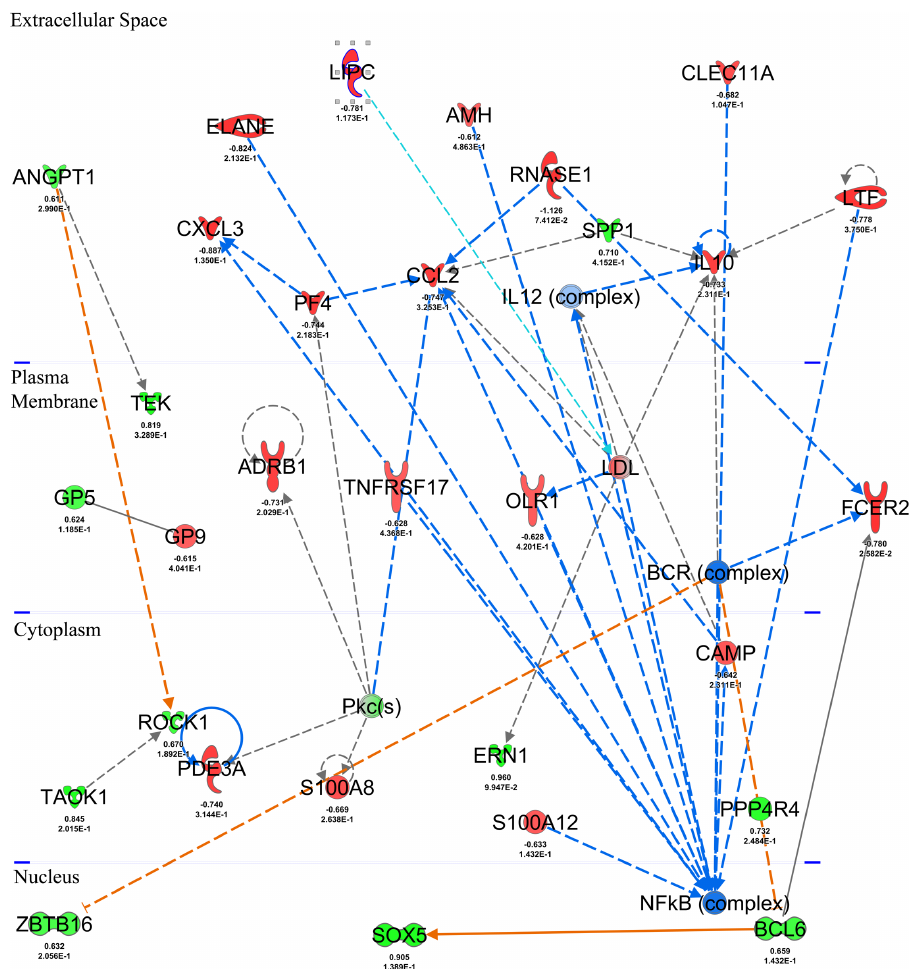
Fig 3. Ingenuity top gene network interaction reflecting immune response-related transcriptome changes after consumption of LGG. Nodes in the interaction network are encoded by differentially expressed genes detected by edge-R in blood from subjects consuming LGG for 28 days, up-regulated genes are depicted in shades of green and down-regulated genes are in shades of red. Transcriptional information derived from IPA knowledge database on interactions between the nodes (activation, expression, molecular cleavage or phosphorylation) was projected onto the interaction map with predicted downregulation effects represented with blue dashed lines and upregulation effects with orange lines. From this interaction map it can be seen that several downstream genes including growth factors, peptidases, G- coupled receptors and cytokines that are known to be regulated by NF-KB transcription factor are down- regulated.